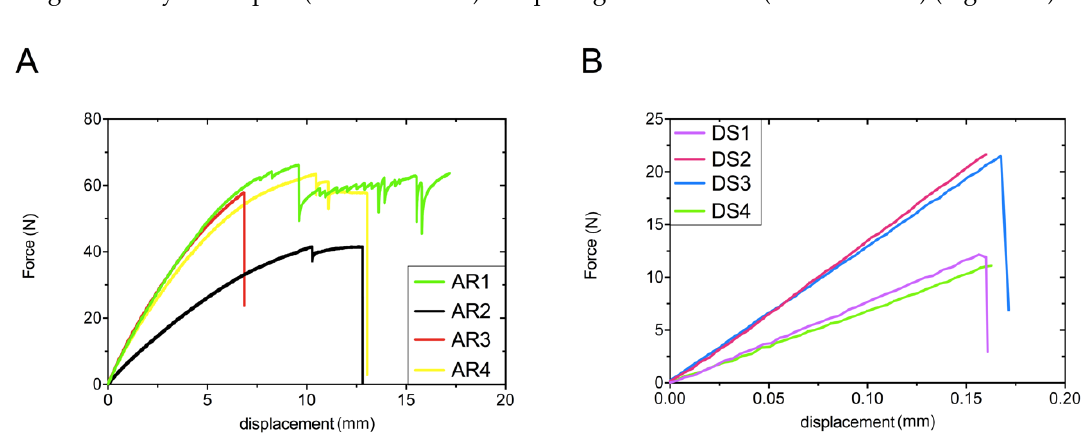
Figure 5. The force/displacement curves of acrylic ( A ) and stone samples ( B ) obtained during flexural strength evaluation. AR and DS means acrylic resin and dental stone, respectively (1–4 are the numbers of tested specimens).